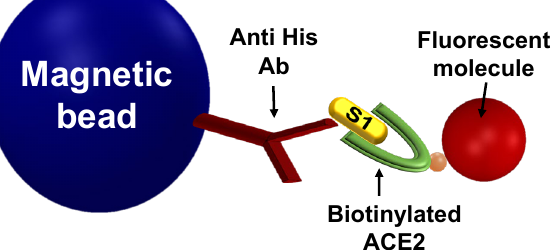
Figure 1. An MMB-based inhibitor screening assay of the S1-ACE2 interaction. Magnetic beads that are conjugated to anti-His antibodies are introduced to S1 recombinant protein. Then, biotinylated ACE2 protein is added and detected using a fluorescent molecule, such as streptavidin R-phycoerythrin (SA-PE).